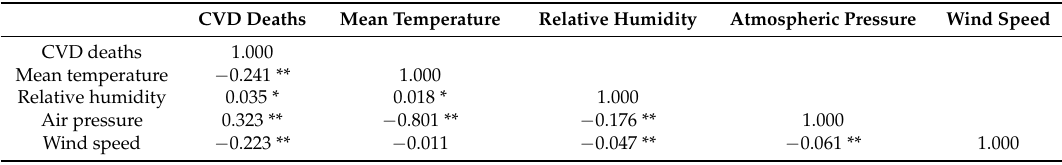
Table 2. Spearman’s correlation between daily CVD deaths and weather variables. CVD Deaths Mean Temperature Relative Humidity Atmospheric Pressure Wind Speed CVD deaths 1.000 Mean